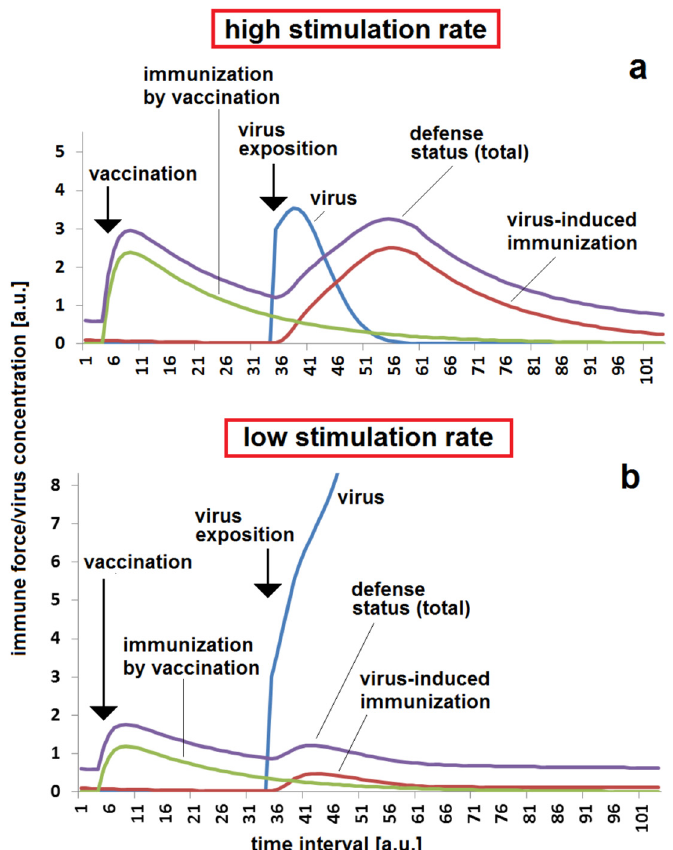
Figure 4. Immunization status, reaction and breakthrough of infection with respect to the stimulation of a specific immune response by virus exposition in the case of a moderate time span between vaccination and virus exposition: ( a ) sufficient protection by a combination of vaccination and strong stimulation of immune response by viral infection, k st = 0.12; ( b ) non-sufficient protection due to decay of immunization after vaccination and low stimulation rate of immune response by viruses, k st = 0.06. The set of other parameters for both simulations ( a , b ): k r = 0.12; k vir = 0.3; D vacc = 0.05; D AB = 0.05; c BGim = 0.5; v oo = 30; st oo = 10.